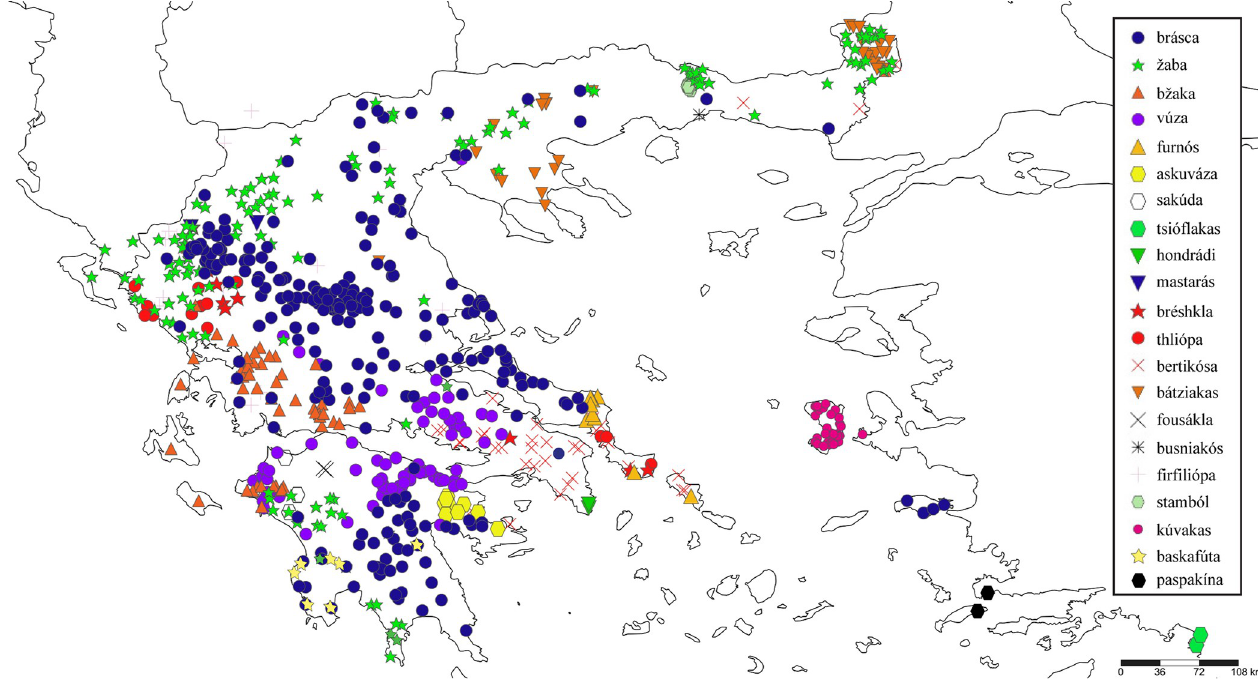
Fig 1. Sampling locations where the main zoonyms of the common toad were recorded, both in the field and through social media. The number of sites does not equal the total number of informants, as multiple individuals were interviewed from each locality. Zoonyms of limited geographic range are not